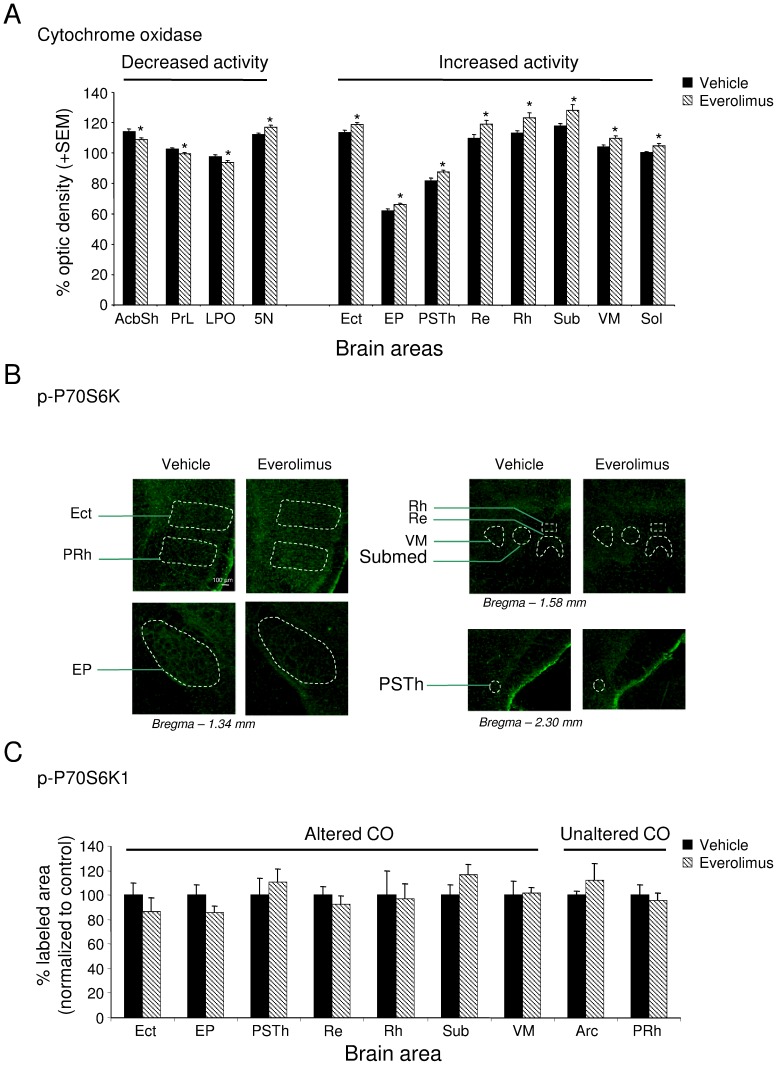
Phospho-P70S6K labeling in brain regions of everolimus and vehicle mice.(a) CO activity in selective vehicle- and everolimus-treated mice brain areas. (b) Representative images of Phospho-P70S6K (p-P70S6K) immunolabeling in cortex, entopeduncular nucleus, thalamus and hypothalamus of vehicle or everolimus-treated mice. (c) Mean percent of P-P70S6K-labeled surface (normalized to vehicle) (+SEM) in the different brain areas. Arc: arcuate nucleus; Ect: ectorhinal cortex; EP: entopeduncular nucleus; PRh: perirhinal cortex; PSTh: parasubthalamic nucleus; Re: reuniens thalamic nucleus; Rh: rhomboid thalamic nucleus; Submed: submedial thalamic nucleus; VM: ventromedial thalamic nuleus.